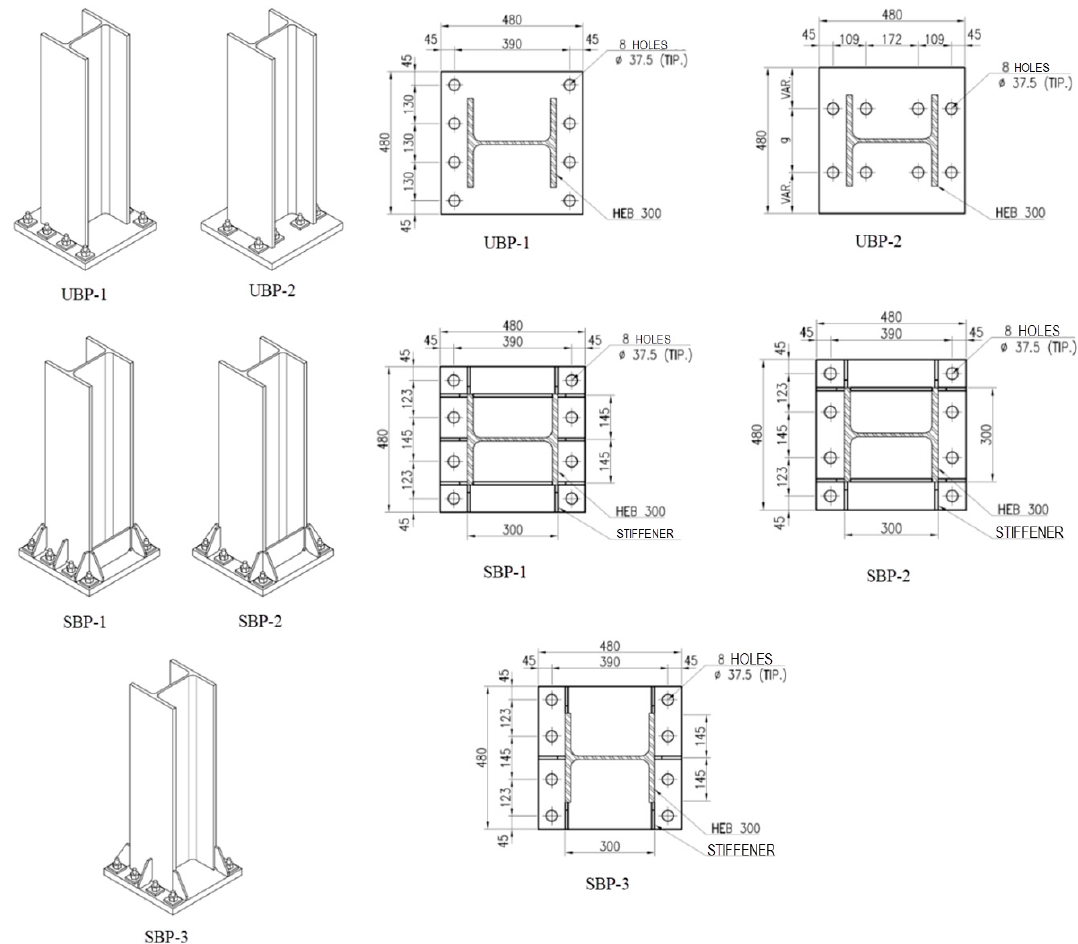
Figure 1. Specimen Figure 1. Specimen configurations.